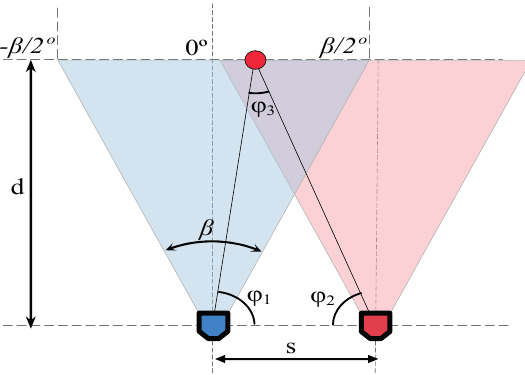
Figure 10. Schematic representation of the parameters involved in a distance estimate with a stereovision